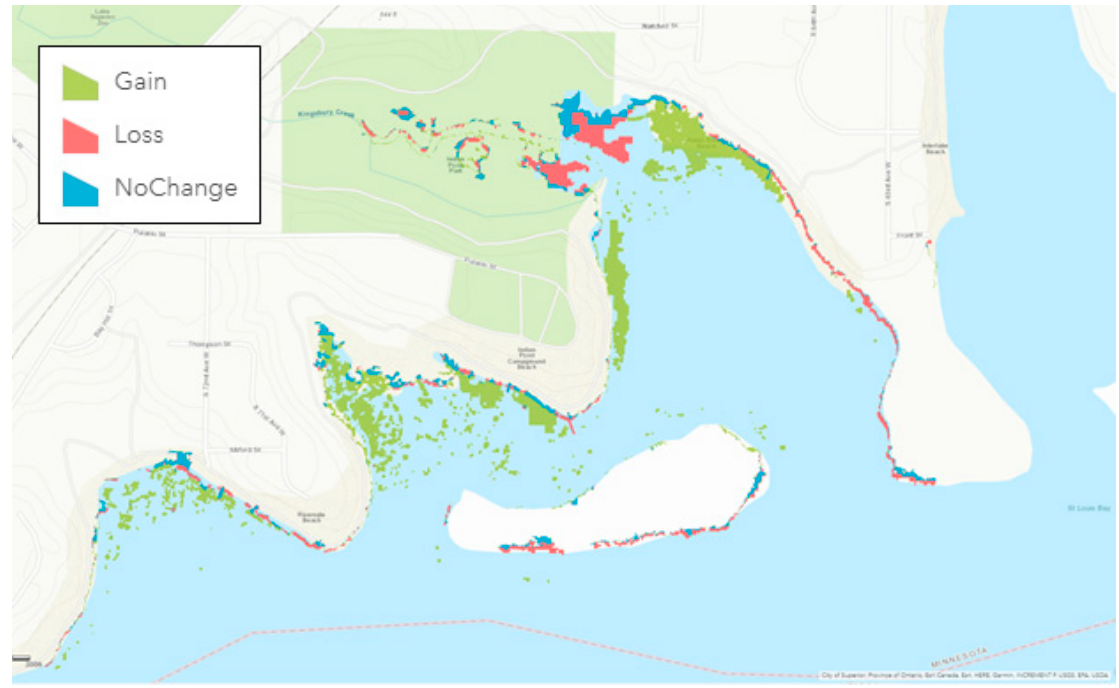
Figure 8. Change detection showing aquatic vegetation gain, loss, and no change near Duluth, MN.